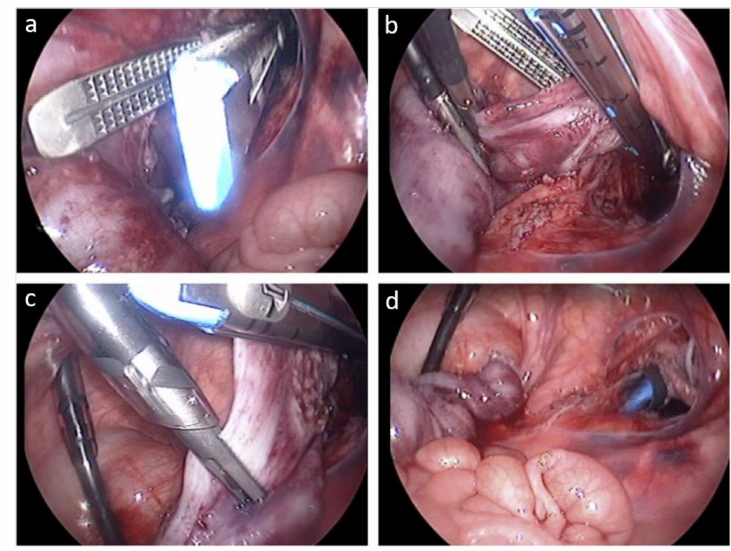
Figure 5. Laparoscopic Duhamel procedure assisted by transrectal NOTES. Three 5 mm transabdominal trocars were combined with a 12 mm transrectal trocar. ( a ) Introduction of the endoscopic stapler, ( b ) adjusting the stapler, ( c ) stapling of the colon, ( d ) situs after transection of the colon. Figure taken from Lamas-Pinheiro 2012